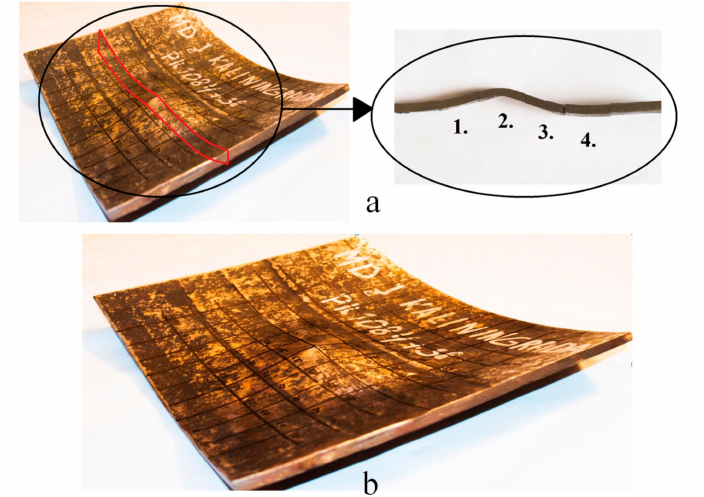
Figure 3. A s chematic view of the preparation of test pieces: ( a ) denotes the disposition of metallographic test pieces; ( b ) denotes the areas of hardness testing.